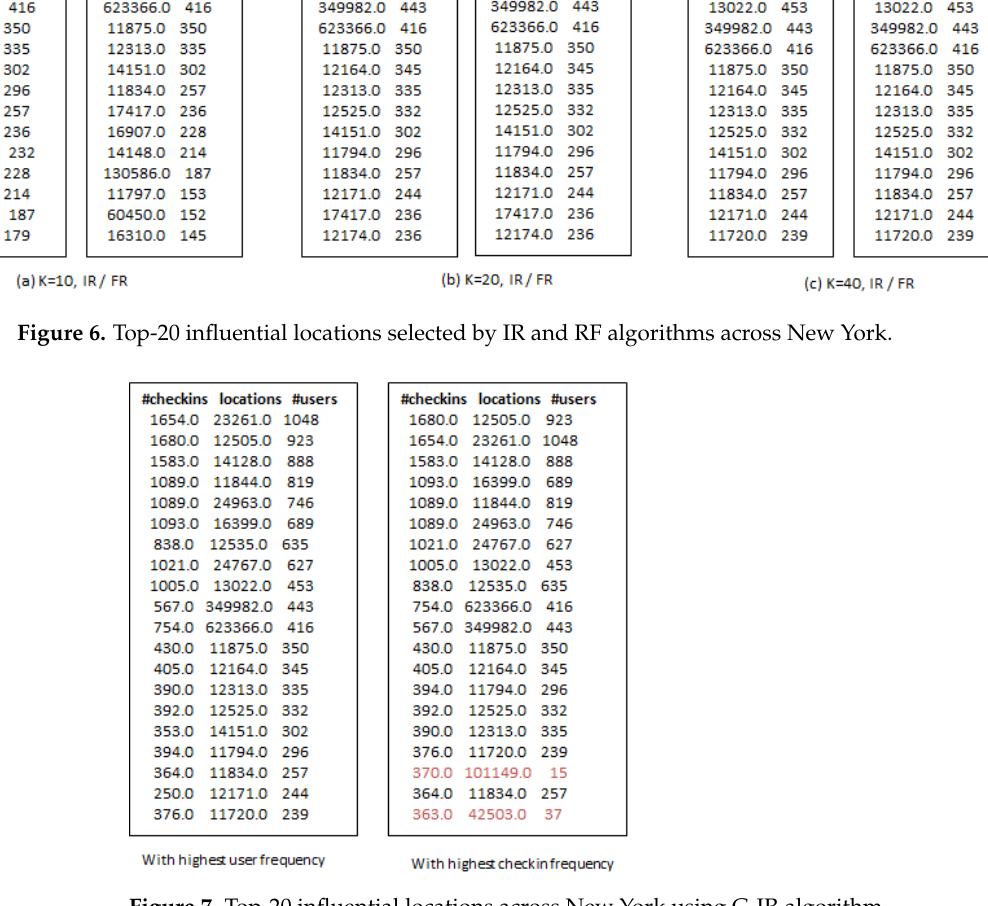
Figure 7. Top-20 influential locations across New York using G-IR algorithm.